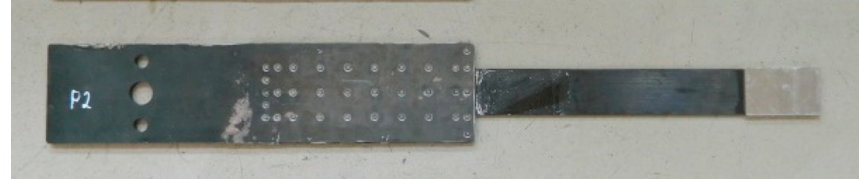
Figure 7. One-sided N-type anchorage of the NPS II system tested in the S3N-S5N series.